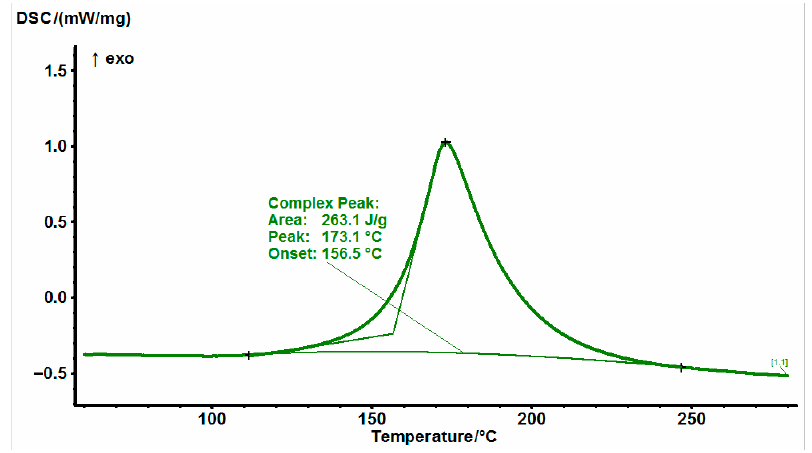
Figure 7. DSC thermograms of non-cured EG514 at a heating rate of 10 °C/min.